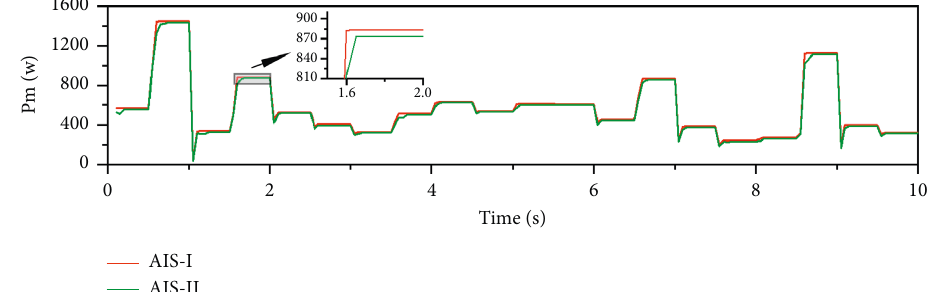
Figure 16: The output power response based on AIS-I and AIS-II